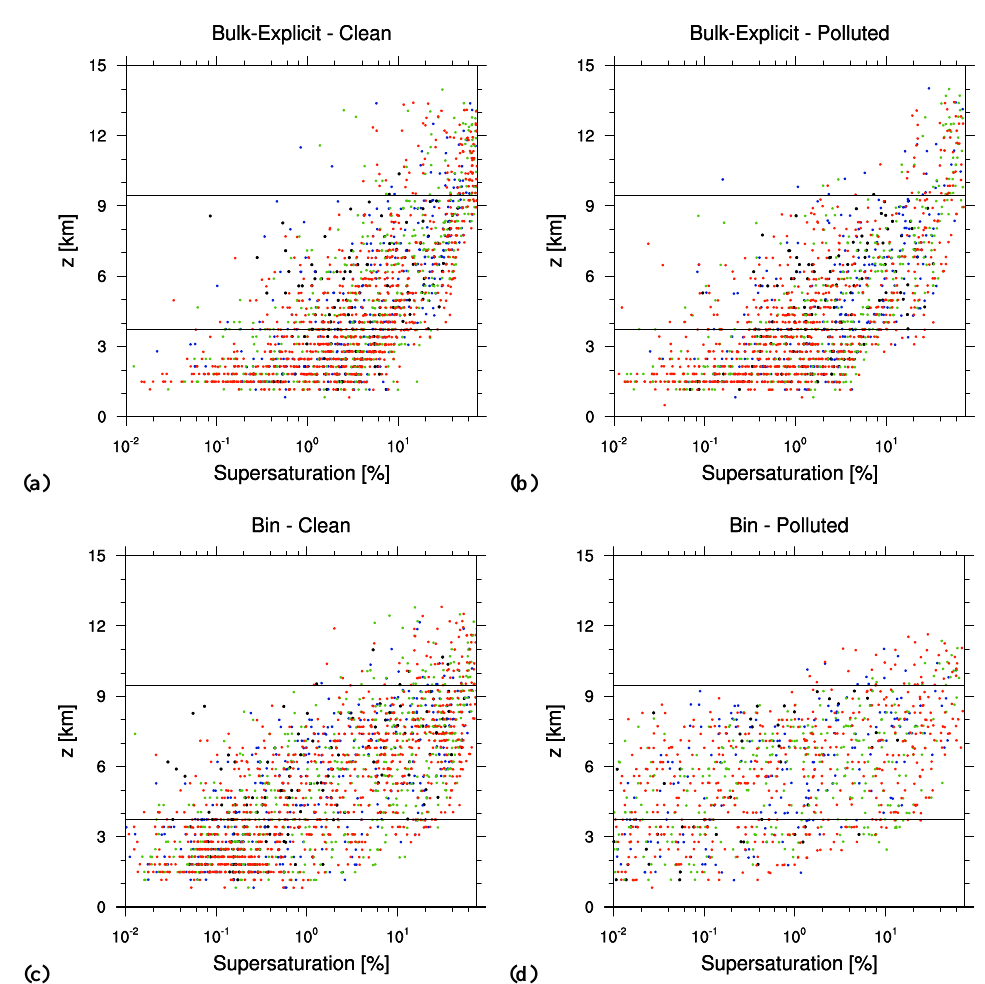
Fig. 13. Scatterplot of ambient supersaturation as a function of height and time. Due to the large data sets, only every 40th point is shown. The colors correspond to 30min (black), 60min (blue), 90min (green), and 120min (red) into the simulations for the bulk-explicit and bin model configurations. The horizontal lines at 3.4 and 10.5km are shown for referencing the mean height of the 0 ◦ C isotherm and the height at which homogeneous freezing of droplets occurs (i.e., about − 38 ◦